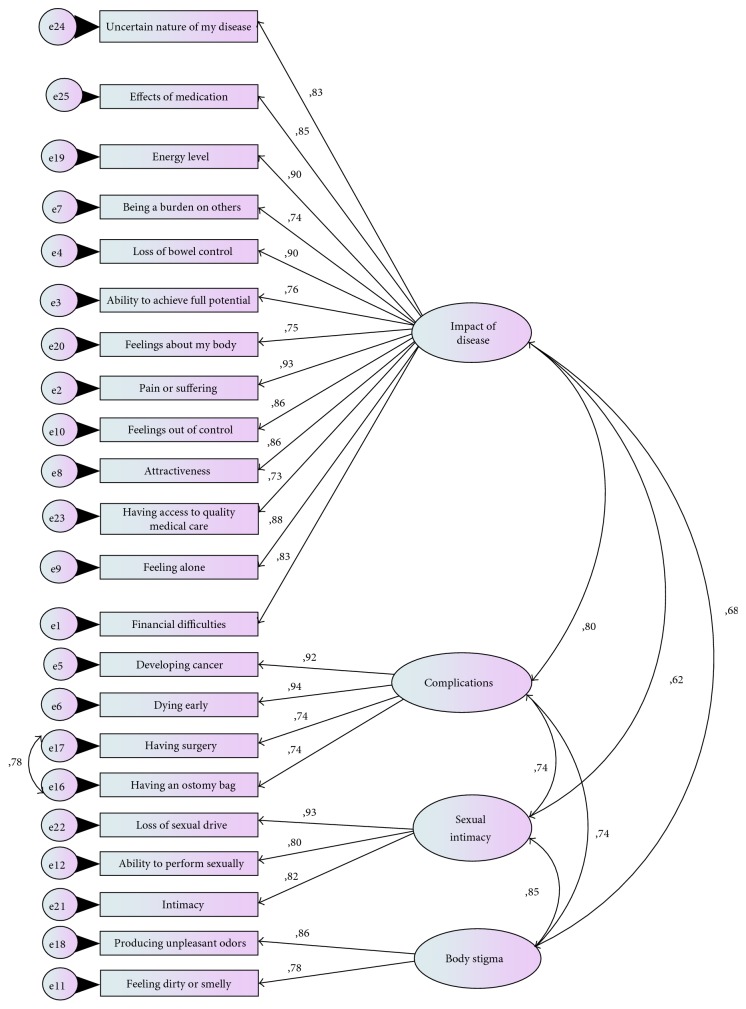
Illustrative representation of the adapted four-structural model of RFIPC (standardised factor loadings).